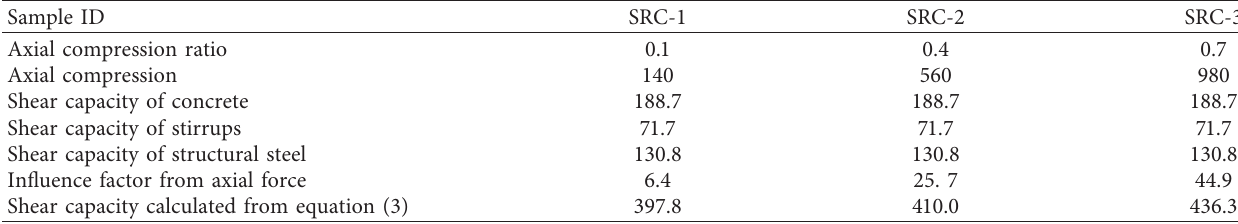
Table 7: Shear capacity calculated by equation (3).